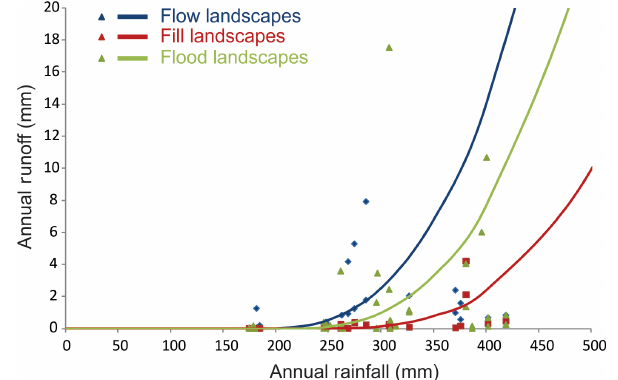
Figure 7. Rainfall–runoff TanH plot (after Grayson et al., 1996) partitioned by landscape position, identifying different hydrologi- cal behaviour in each. This indicates higher runoff from flow land- scapes and the lowest runoff from the fill areas due to high trans- mission losses through in situ vertical recharge, with an intermedi- ate response from flood landscapes that is influenced by these only becoming active during the greatest